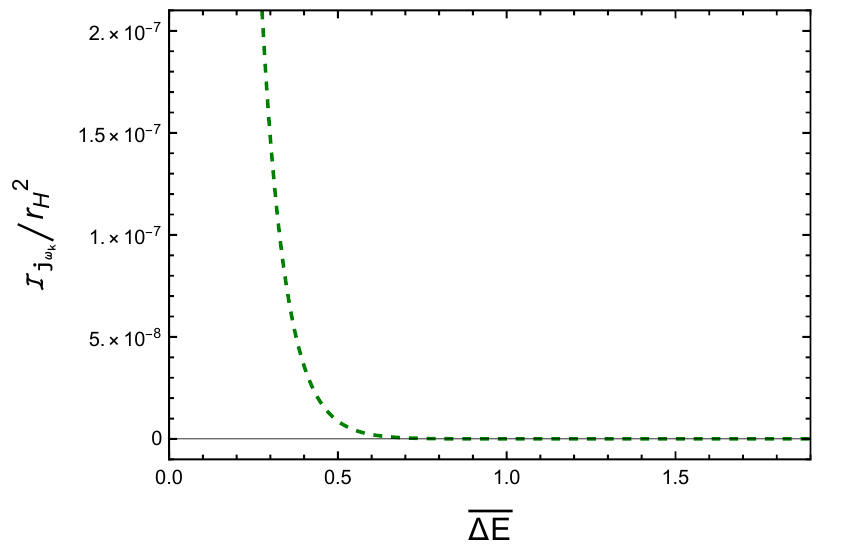
is plotted for two outgoing null detectors in a (1 + 1) dimensional Figure 7 . The quantity I j /r 2 H ωk Schwarzschild black hole spacetime with respect to the dimensionless transition energy ∆ E = r of the detectors, where ∆ E = ∆ E A = ∆ E B . The dimensionless field mode frequency is fixed at is independent of d ω k = 1 . One should note that I j ωk